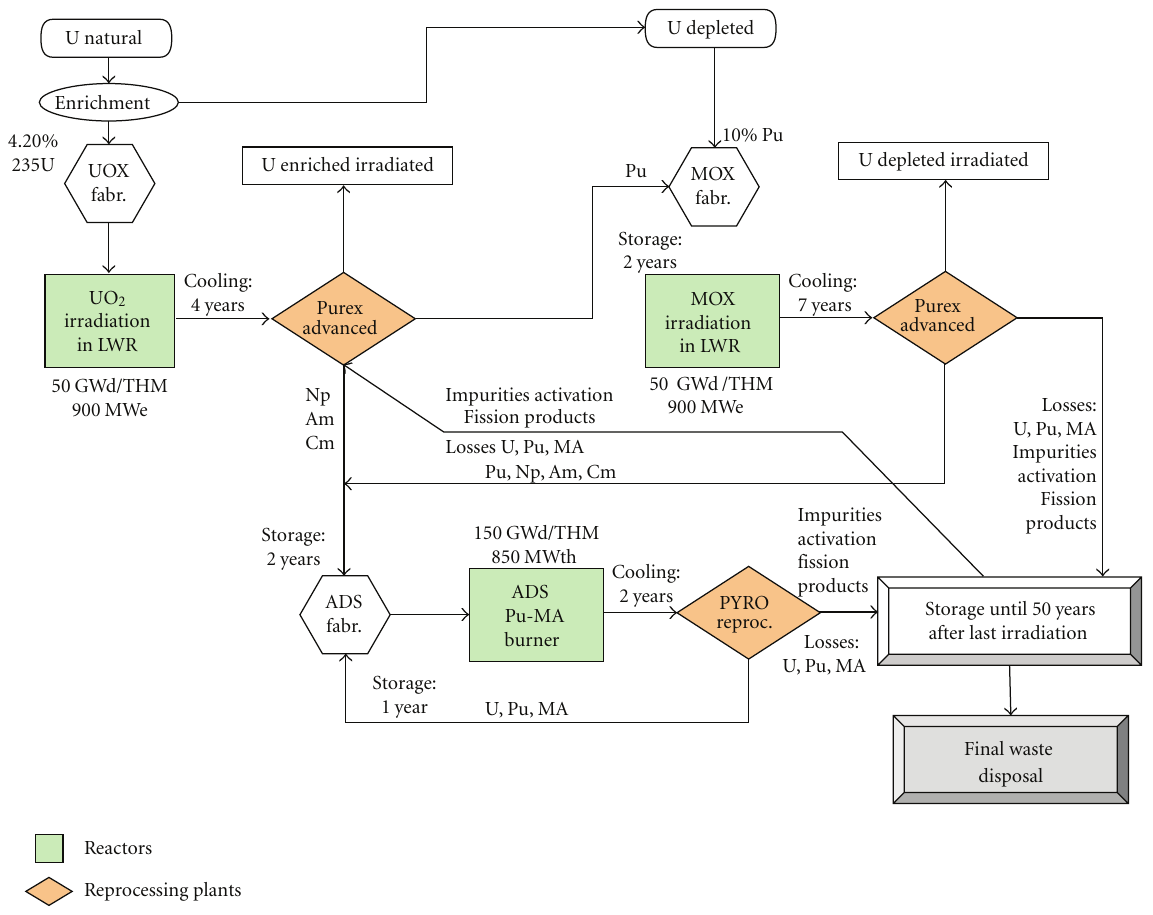
Figure 2: Scheme of the double-strata fuel cycle scenario with LWR and